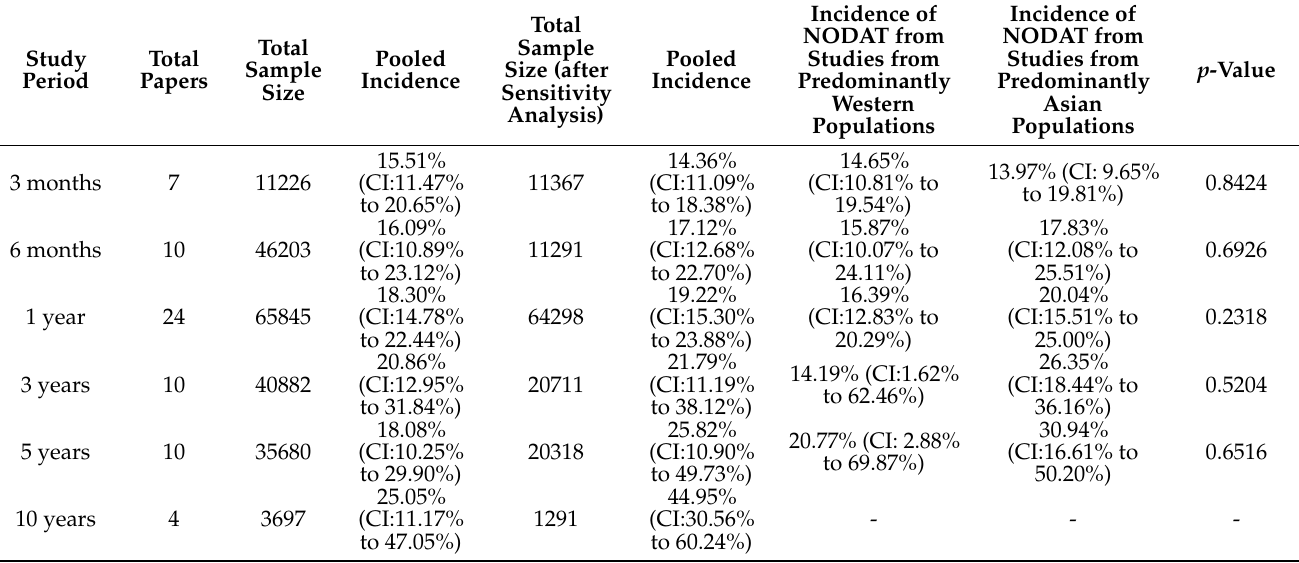
Table 2. Incidence of New-Onset Diabetes after Transplantation (NODAT) after Liver